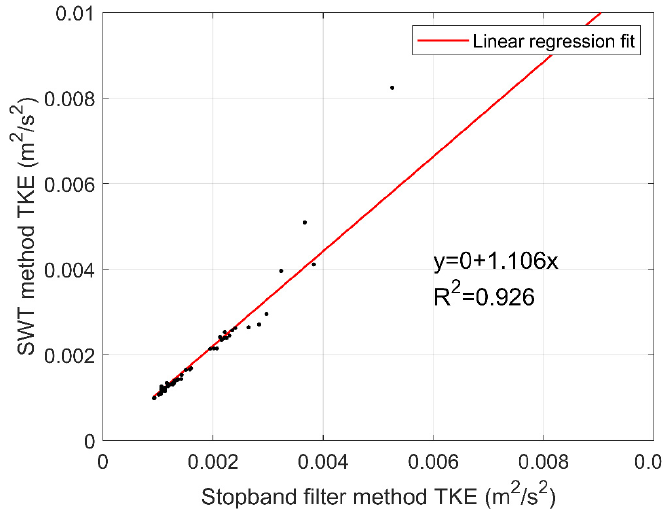
Figure 11. Linear regression fit between vertical TKE estimates at hub-height from instrument CWTb1 obtained with the SB filter and the SWT methods.